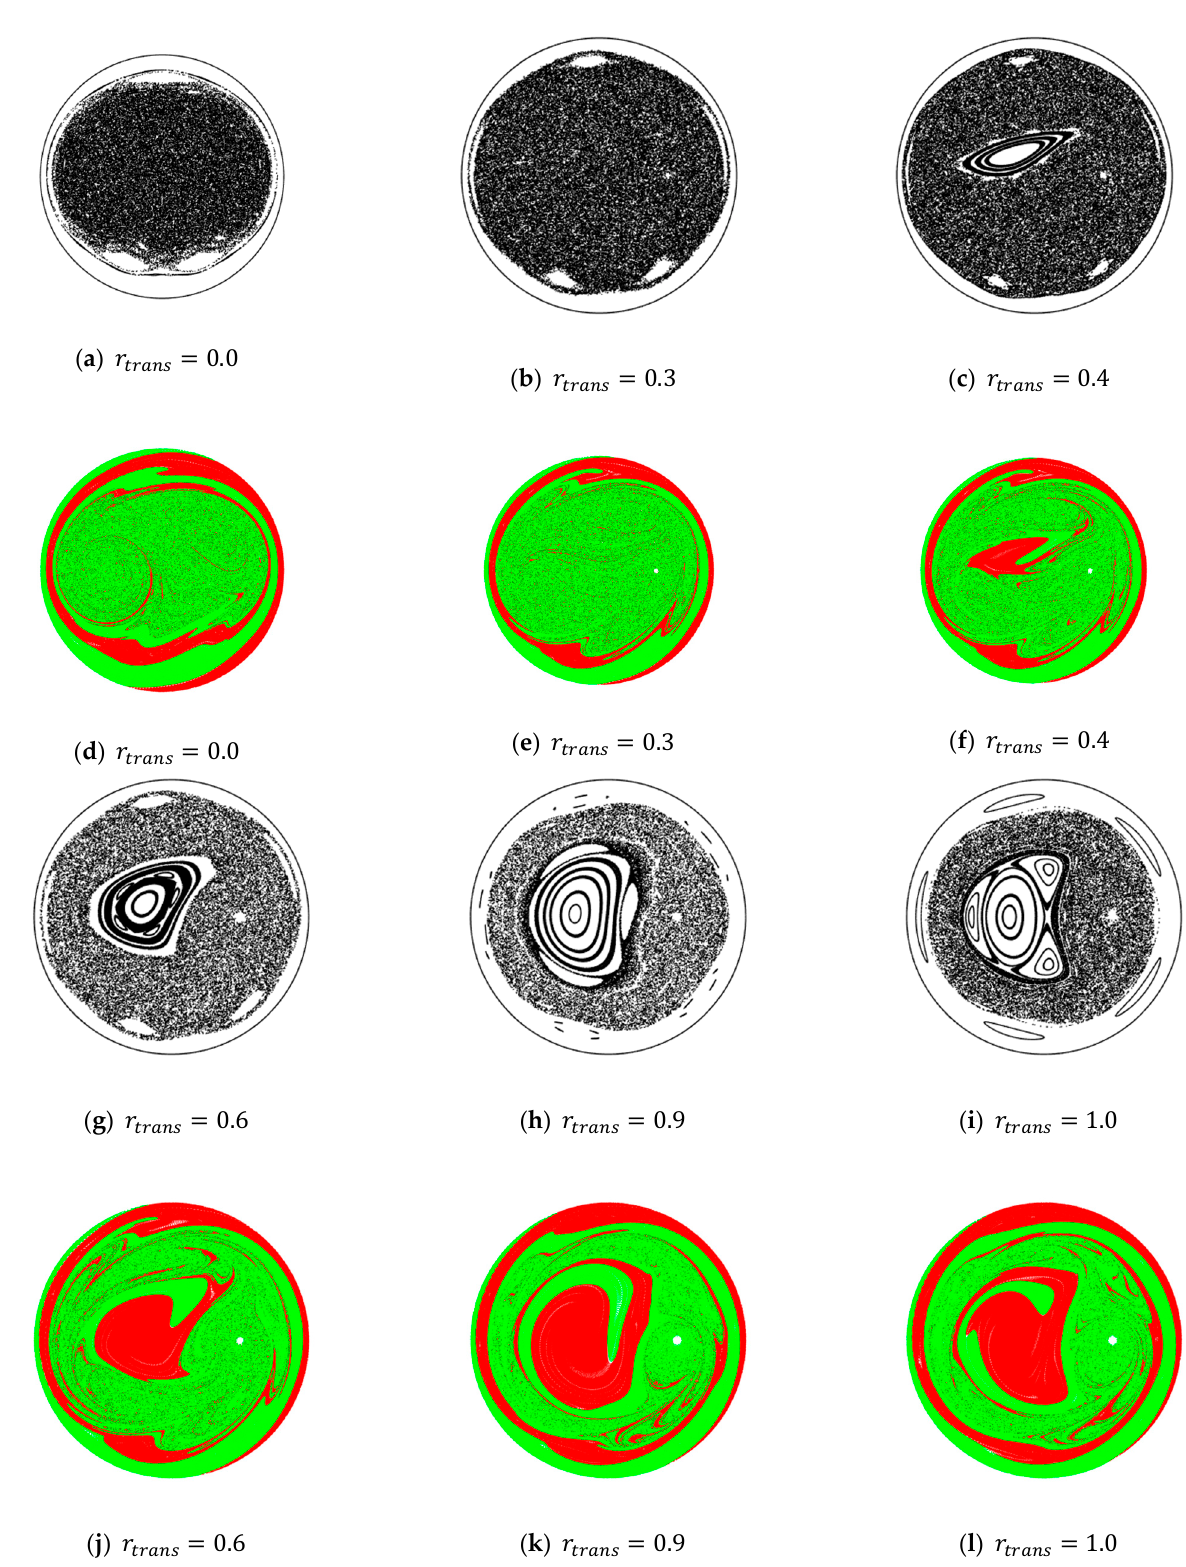
Figure 2. Poincar é sections (the first and third rows) and particle distributions (the second and forth rows) with µ = 1 and ν = 0.5. A total of 5000 iterations were computed to construct the Poincar é sections and the particle distribution plots experience the identical total time, equal to 10.